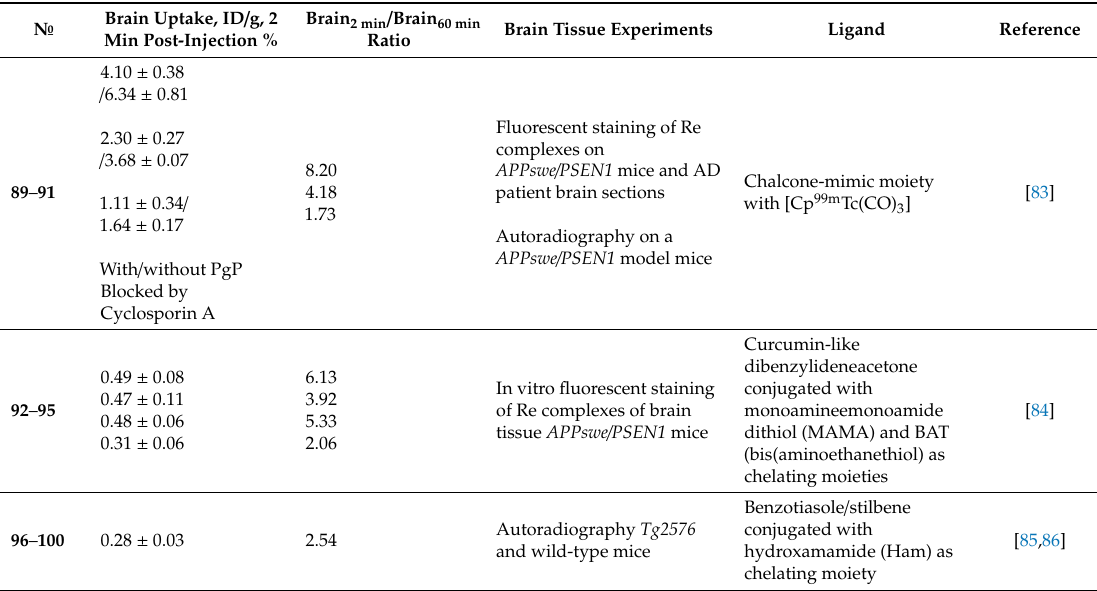
Table 5. 99m Tc coordination compounds for single-photon emission computed tomography (SPECT) visualization of